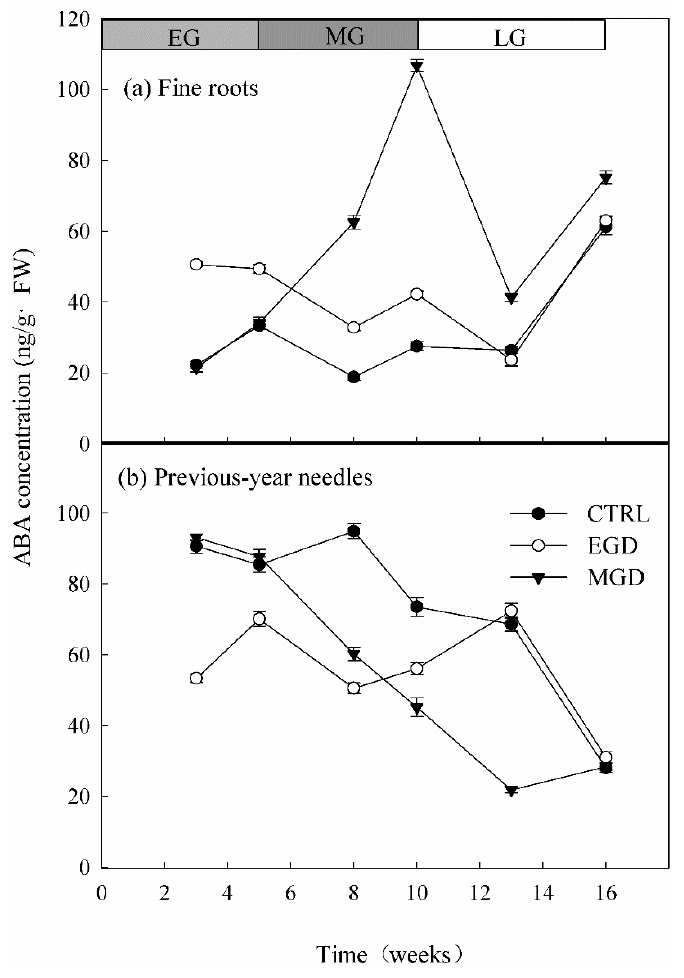
Figure 6. Abscisic acid (ABA) concentration in fine roots ( a ) and previous-year needles ( b ) of Mongolian pine saplings by treatment. CTRL indicates the control. EGD and MGD indicate drought stress treatment in the early- (EG) and mid- (MG) growing seasons, respectively. EG, MG and LG refer to the early- (weeks 1–5), mid- (weeks 6–10) and late- (weeks 11–16) growing season, respectively. Time indicates weeks from the beginning of the experiment. Bars indicate standard error ( n = 4).